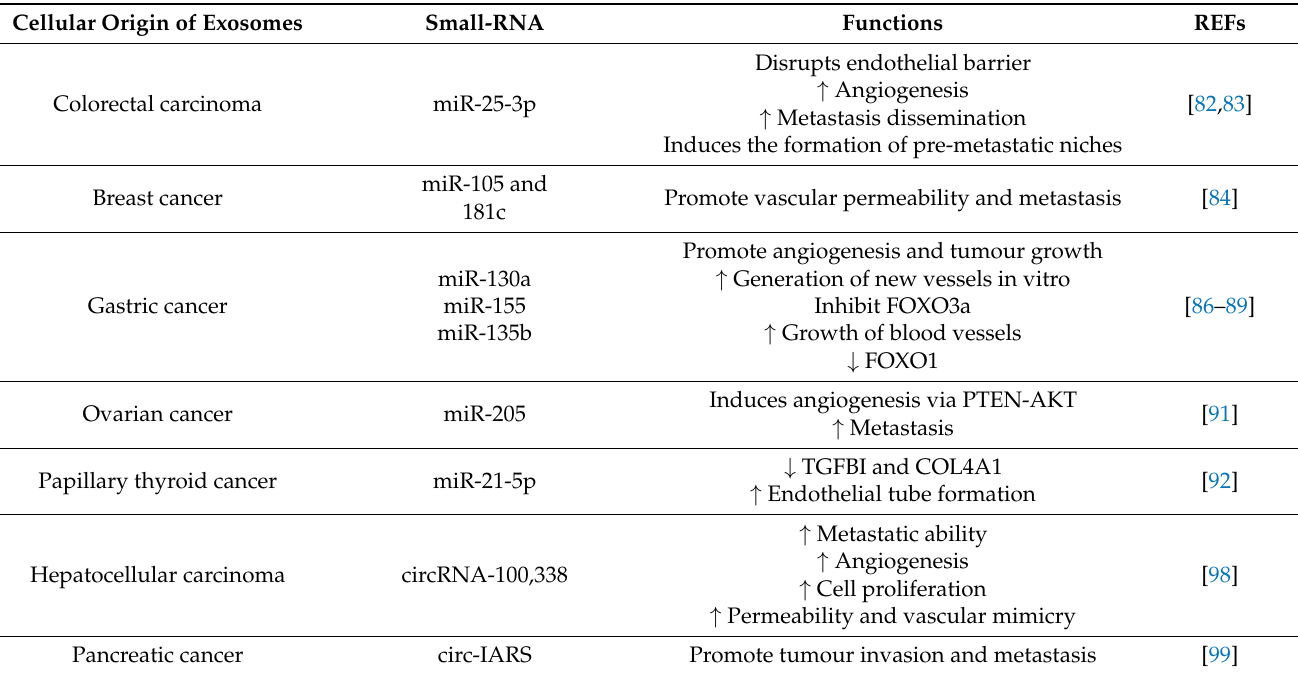
Table 2. Exosomes-borne small RNAs and their functional roles in EC